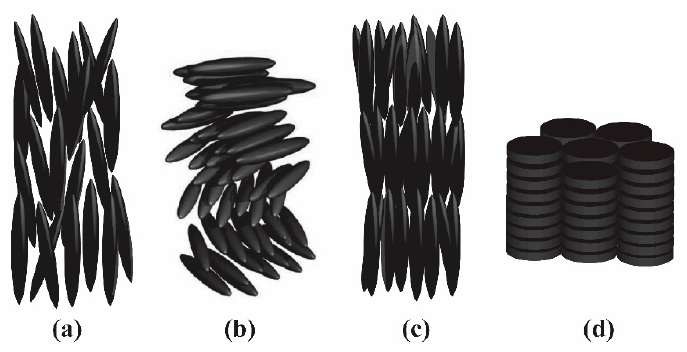
Figure 2. Schematic diagram representing the orientation of nanorods in ( a ) nematic, ( b ) cholesteric, ( c ) smectic A, and ( d ) discotic liquid crystalline phases.